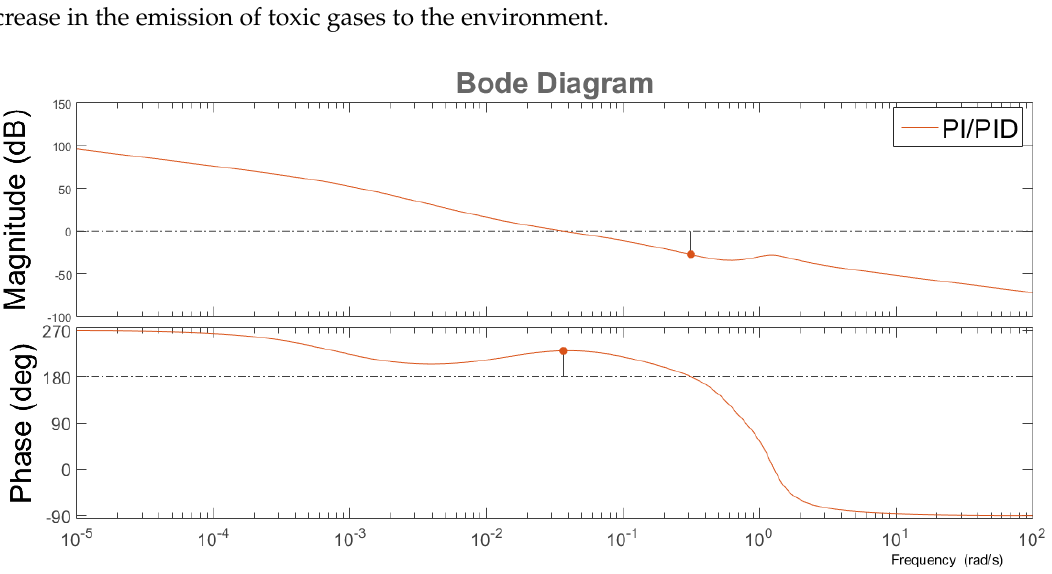
Figure 10. Phase margin of the PI/PID controller against variations in the reference signal and external disturbances.